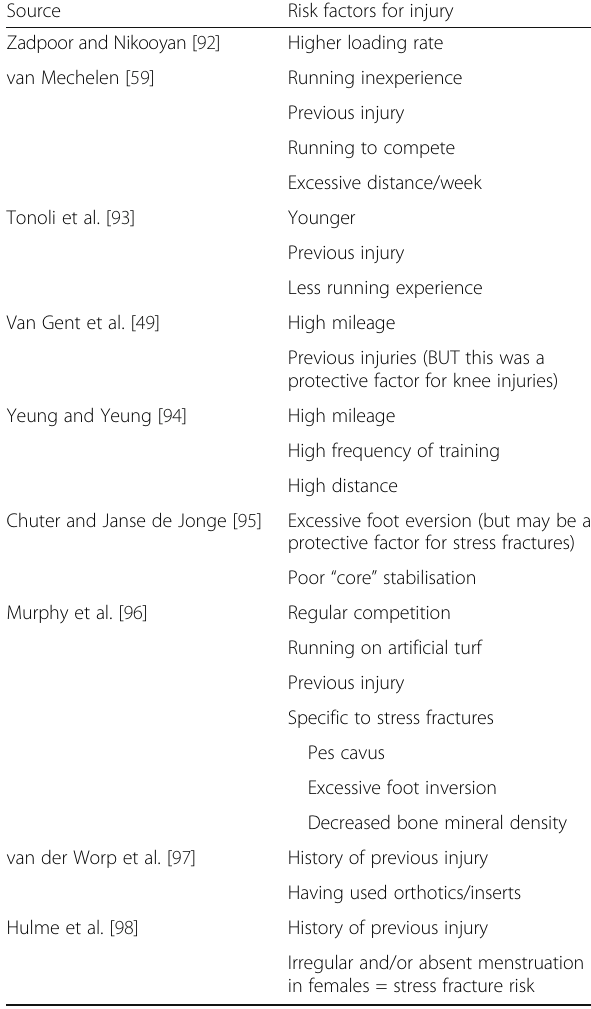
Table 3 A list of possible risk factors for injury in runners. Evidence is only from systematic reviews and meta-analysis and